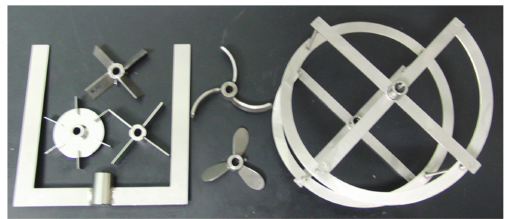
Figure 1: Photograph of several kinds of mixing impellers.